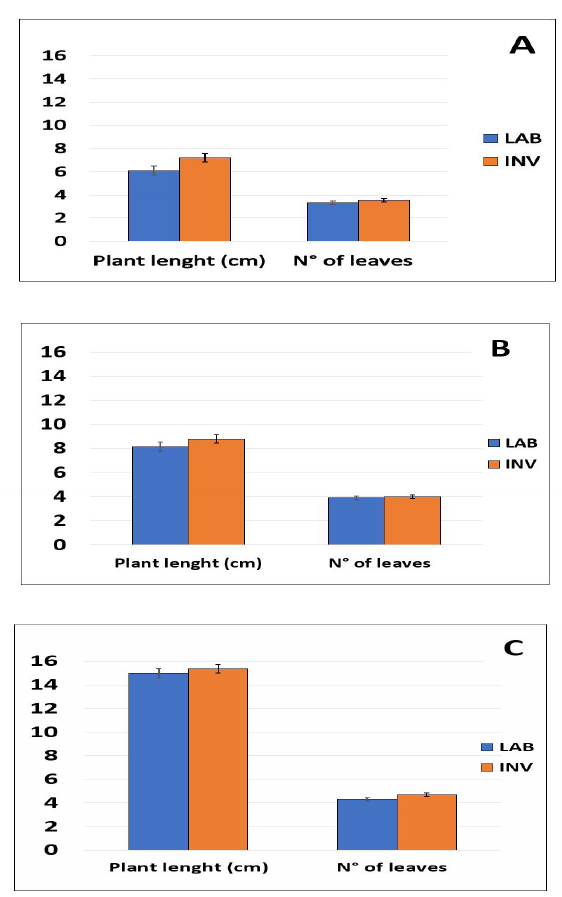
Figure 8. Development of thorny artichoke plantlets ( Cynara scolymus L.) of clonal line L-250 in greenhouse acclimatization stage. (A) At 15 days, (B) at 30 days, and (C) at 45 days. Values are means ± SE (n = 10).